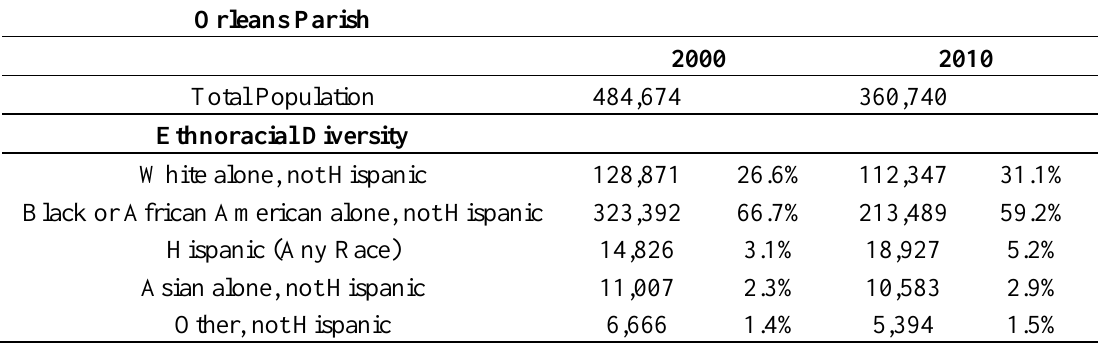
Table 1. Total population and ethnoracial population in New Orleans,